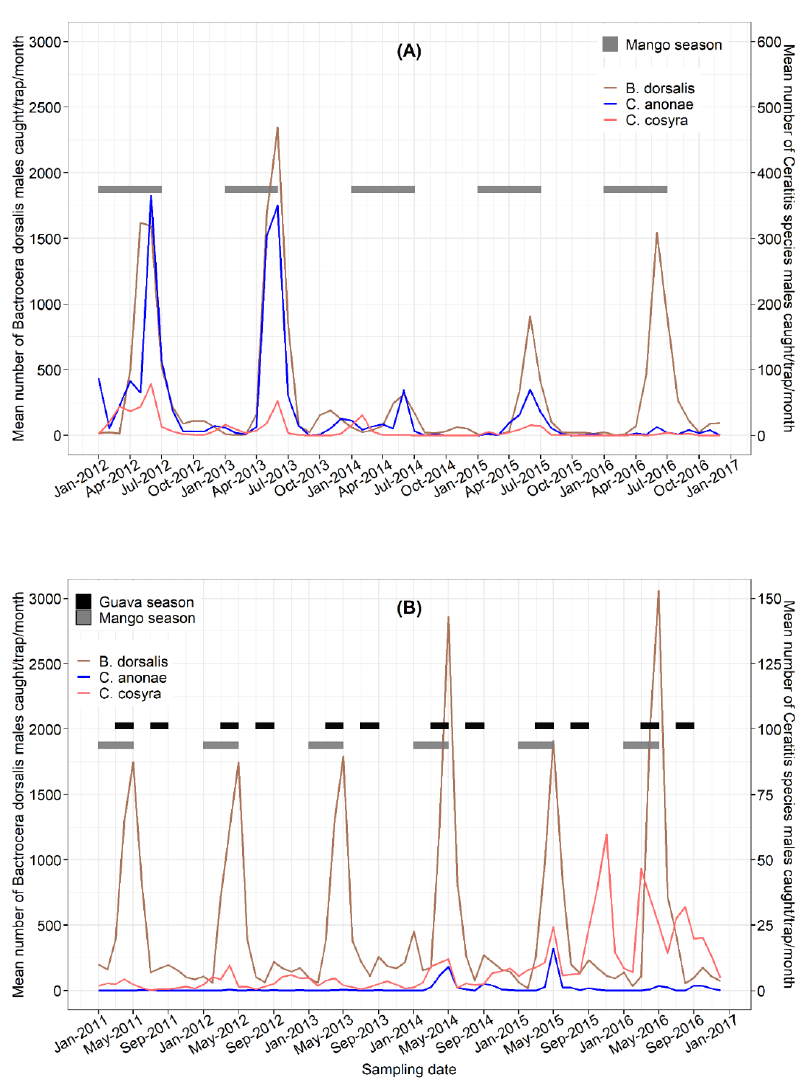
Figure 3. Yearly dynamics of tephritid fruit fly males in traps baited with methyl eugenol ( Bactrocera dorsalis ) and terpinyl acetate ( Ceratitis cosyra and C. anonae ) in Foumbot WH-MR ( A ) from January 2012 to January 2017, and Nkolbisson HF-BR ( B ) from January 2011 to December 2016, in relation to the ripening periods of mango and guava.